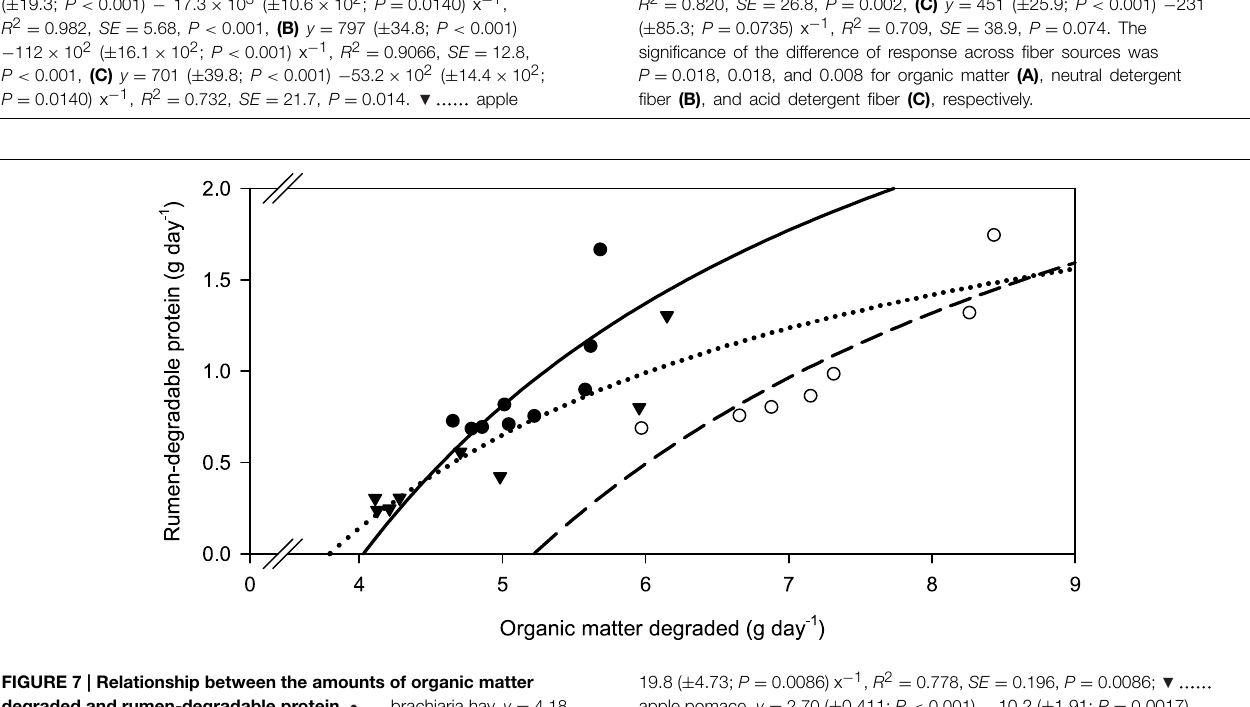
19.8 ( ± 4.73; P = 0 .0086) x − 1 , R 2 = 0 . 778 , SE = 0 . 196 , P = 0 .0086; ▼ apple pomace, y = 2 . 70 ( ± 0.411; P < 0 . 001 ) − 10.2 ( ± 1.91; P = 0 .0017) x − 1 , R 2 = 0 . 827 , SE = 0 . 166 , P = 0 .017. The significance of the difference of response across fiber sources was P < 0 . 001